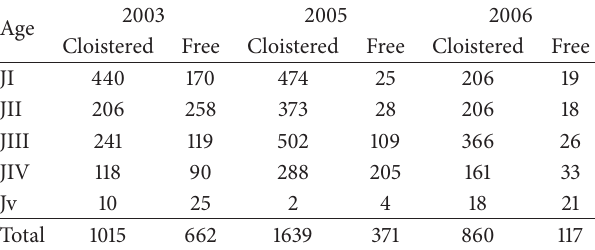
Table 1: Sterna hirundinacea chicks captured and monitored during the 2003, 2005, and 2006 breeding